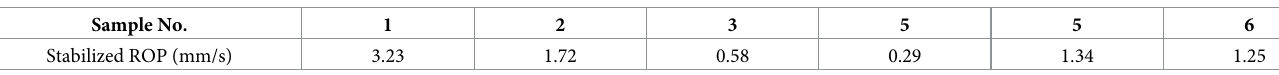
Table 3. The stabilized ROP for each specimen. Sample